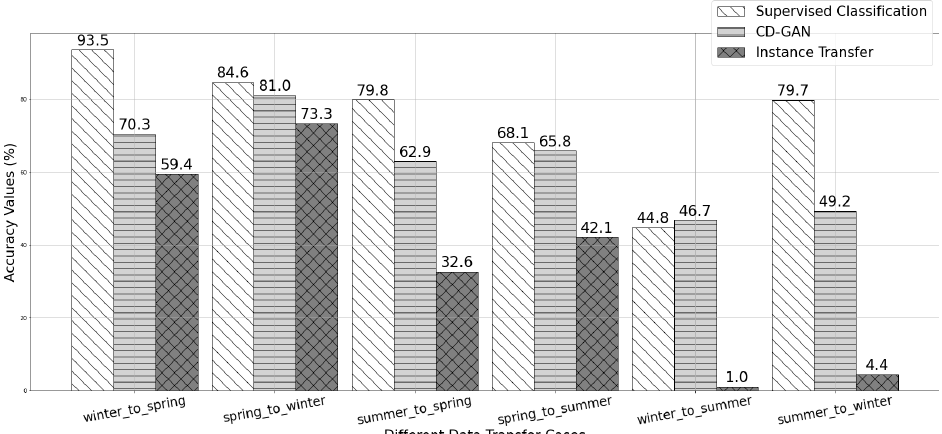
Figure 5. Comparison of the classification performance of classifiers trained using ground truth data on identifying data obtained from different sources. Bars filled with cross stripes: ground truth testing data, denoted as full-knowledge supervised classification (upper bound). Bars filled with diagonal stripes: ACDG generated fault data. Bars filled with grids: data directly borrowed from the source domain, denoted by simple instance transfer (lower